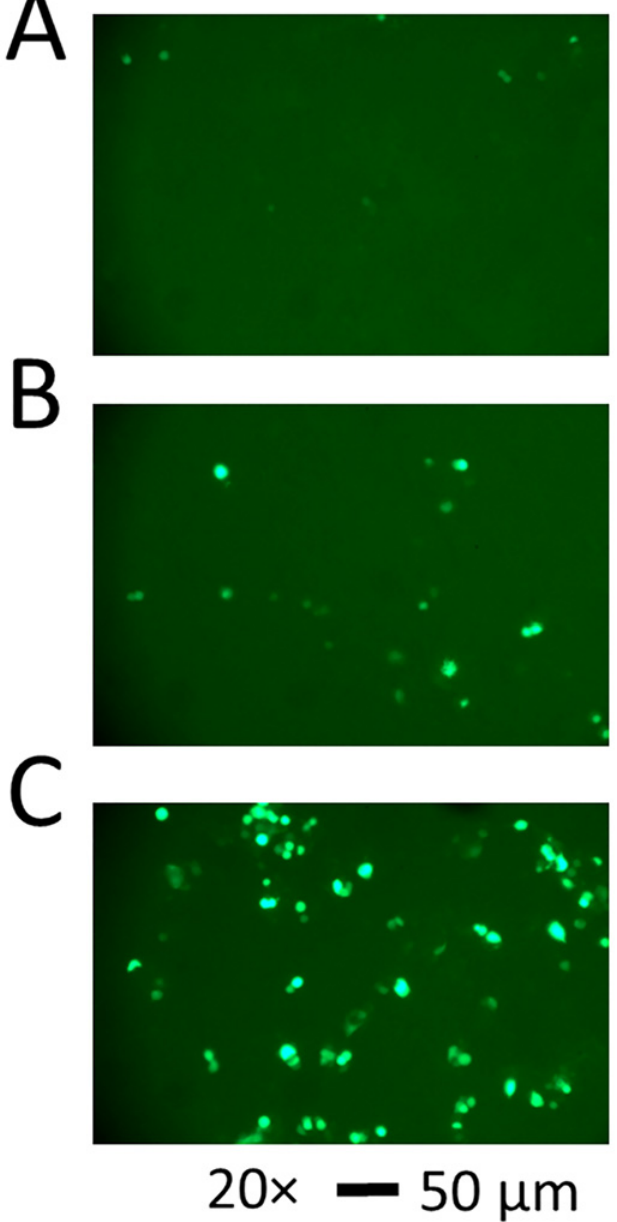
Fig 6. Fluorescence images of GFP-expressing PC12 cells. PC12 cells were transfected with 1 μ g enhanced GFP plasmid DNA in 35 mm dishes using Lipofectamine 2000. Green fluorescence images were taken (34.8x magnification, 1/3 second exposure time, scale bars = 50 μ m). In (A), the cells were maintained at 37°C, whereas in (B) the cells were transferred to 33°C on day 2. The images were taken at 96 hours after transfection. The percentage of the green cells was ~2% and ~6% for (A) and (B), respectively. In (C), when the cells were trypsinized during the passage or one day before transfection, the percentage of green cells was ~18%. As the comparison, the cells in (B) were not trypsinized. Like the cells in (B), the cells in (C) were also transferred to 33°C one day later.